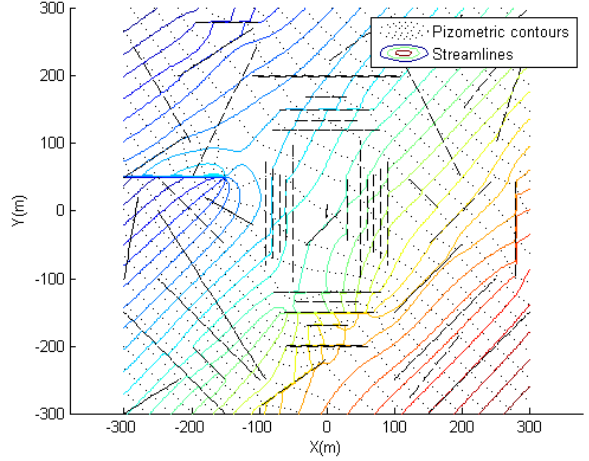
Figure 9. 50 fractures with uniform flow and a well having parameters in Table 3.